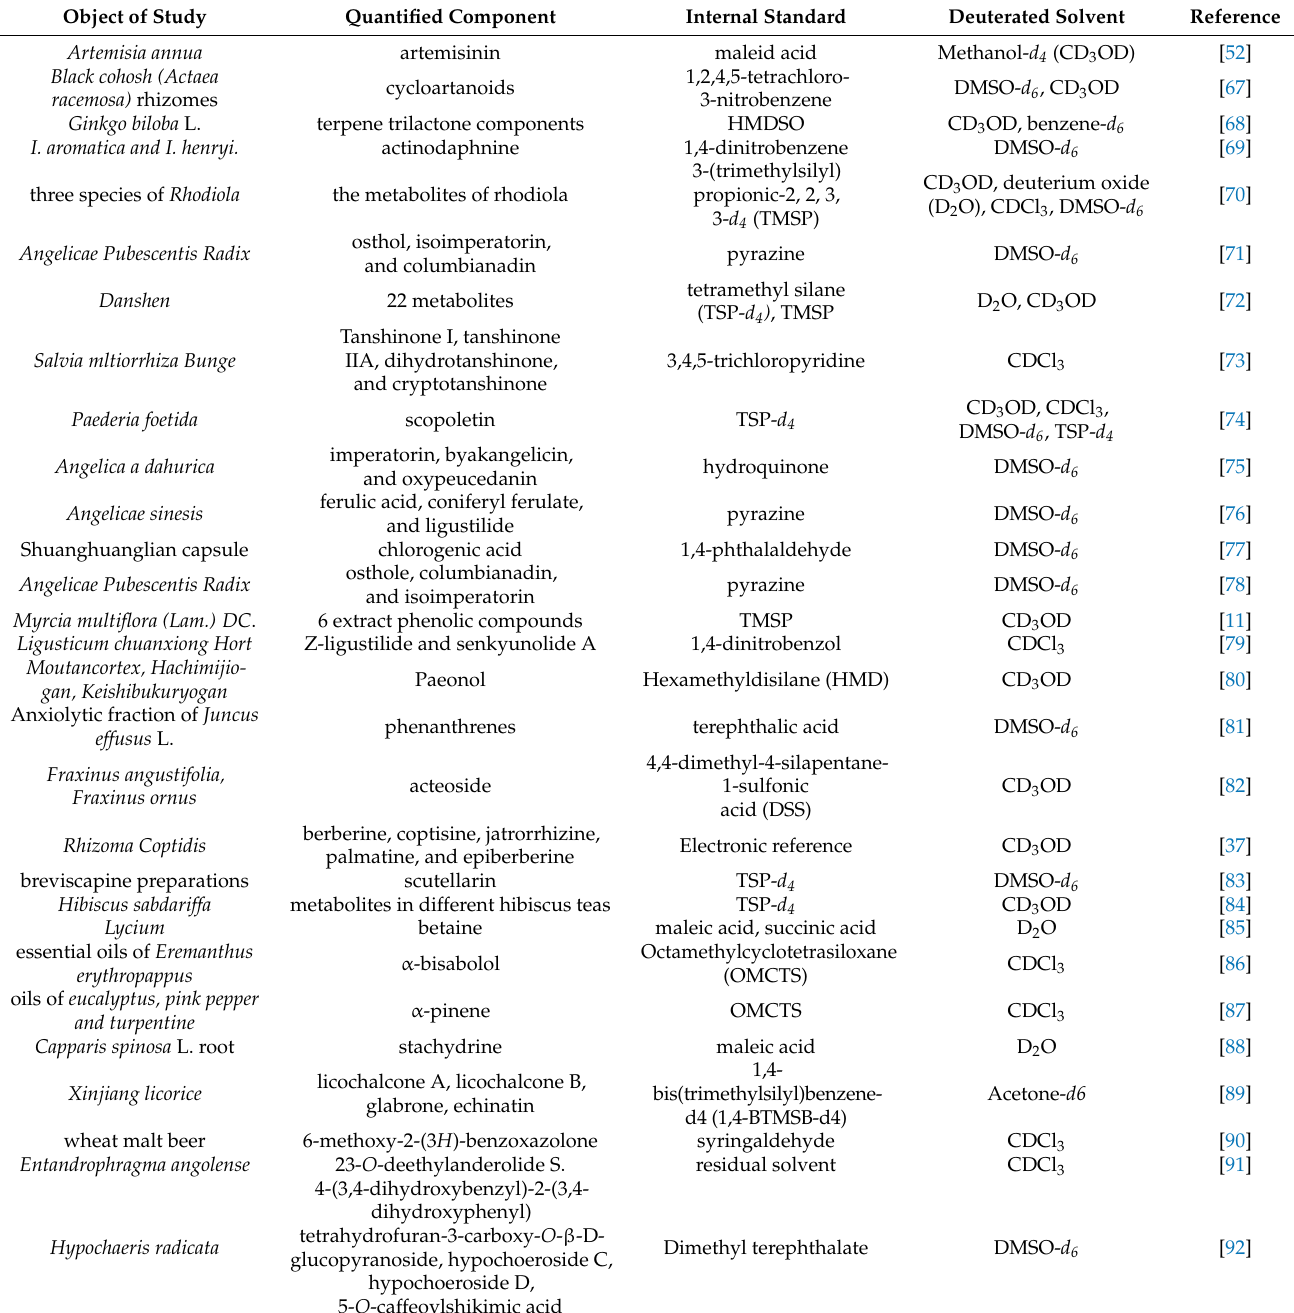
Table 1. Natural products determined by nuclear magnetic quantitative